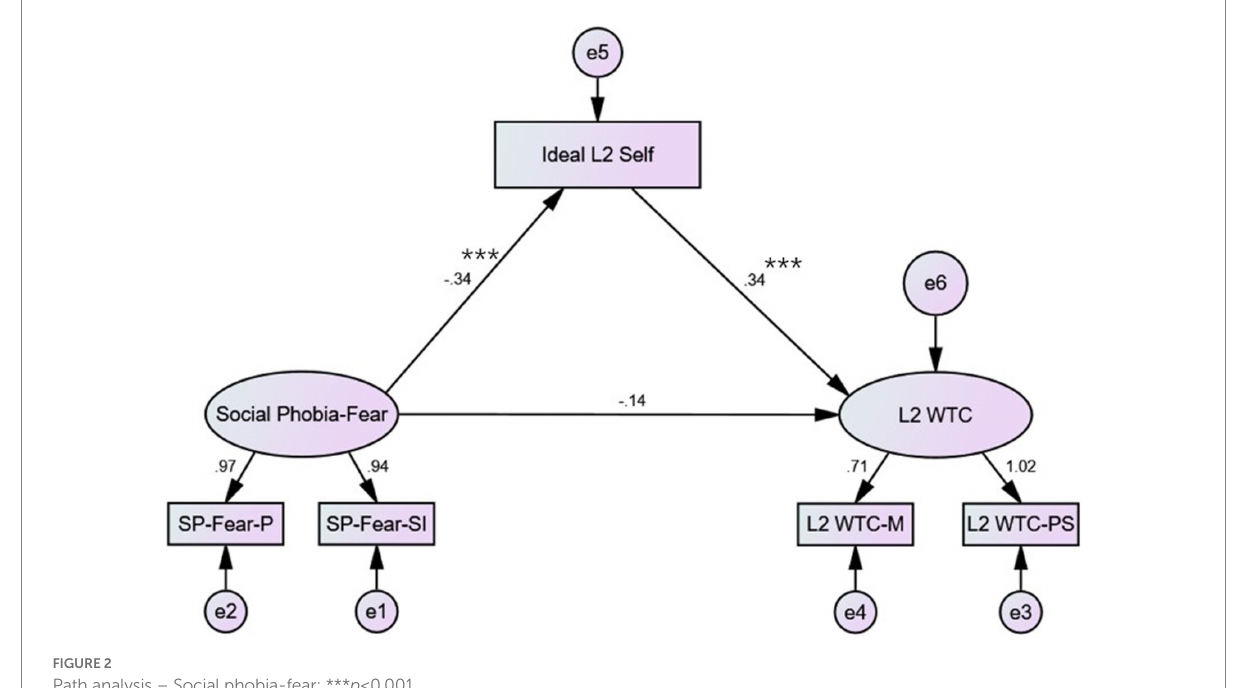
FIGURE 2 Path analysis – Social phobia-fear; *** p < 0.001.